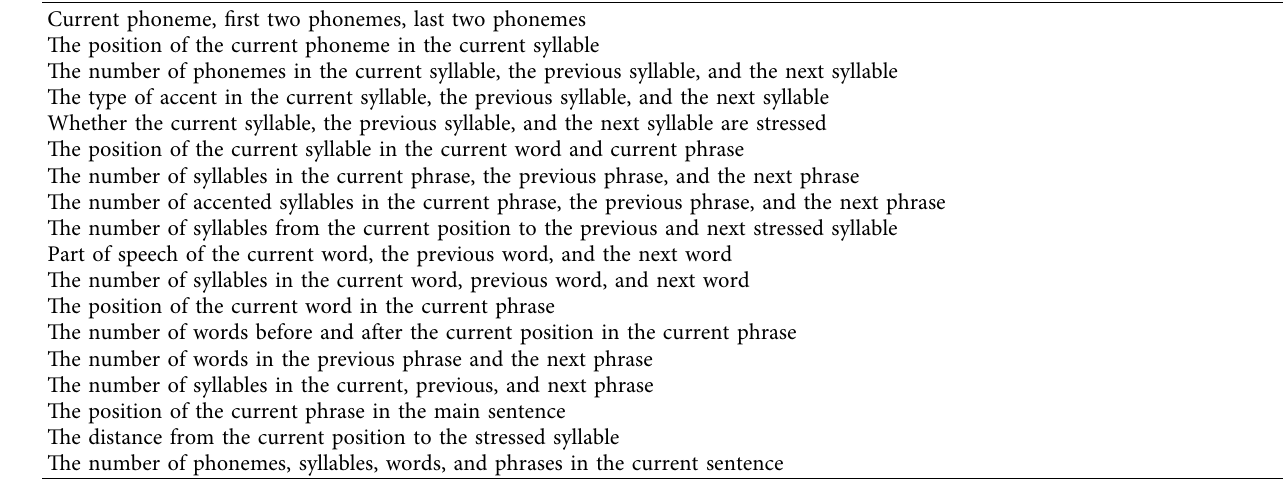
Table 1: Context